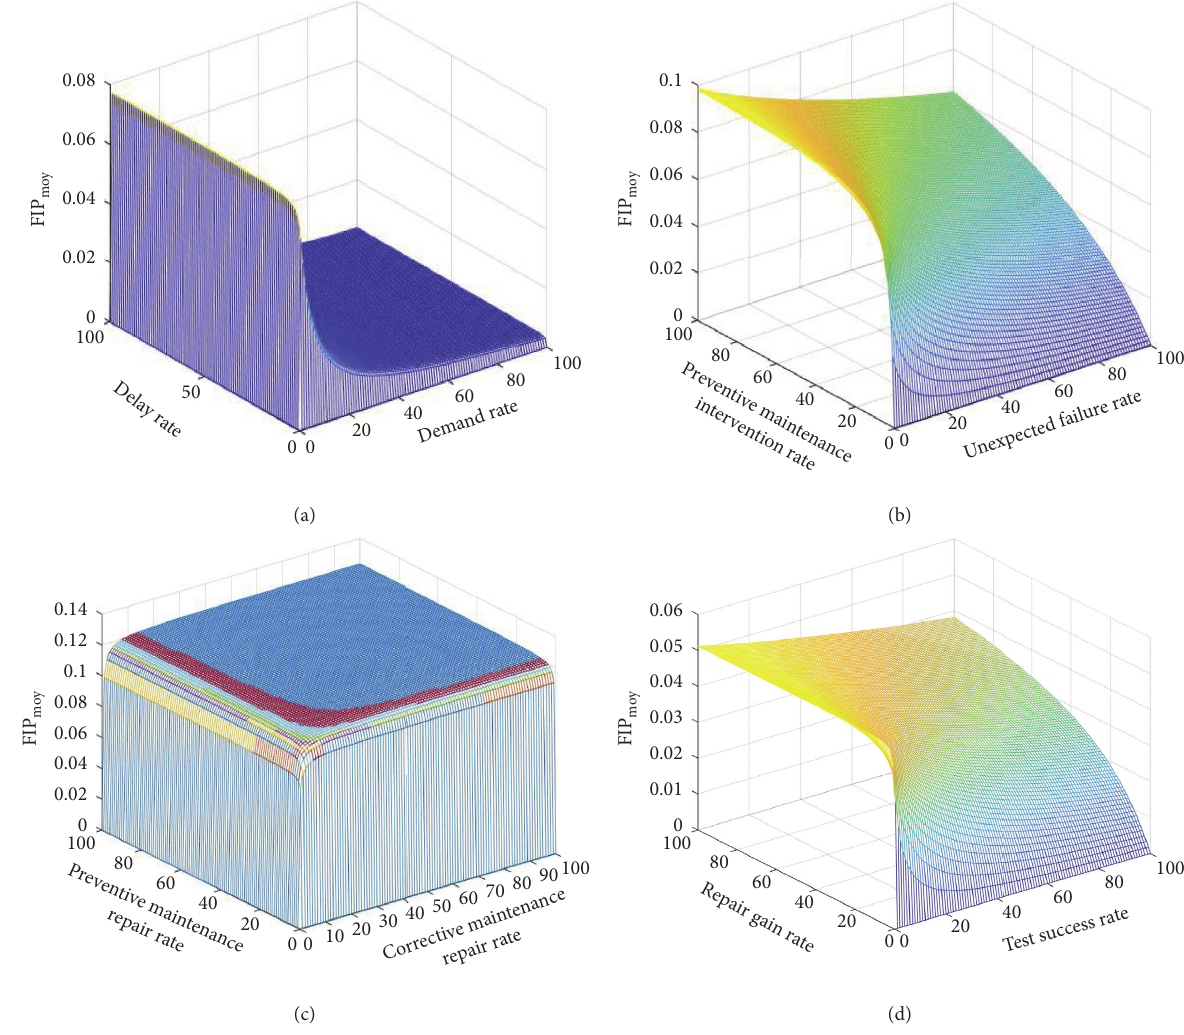
Figure 9: Preventive interventions. (a) Variation of demand and delay rates. (b) Rate variation of unexpected failure and maintenance interventions. (c) Repair rate variation for corrective and preventive maintenance. (d) Test rate variation (repair again or